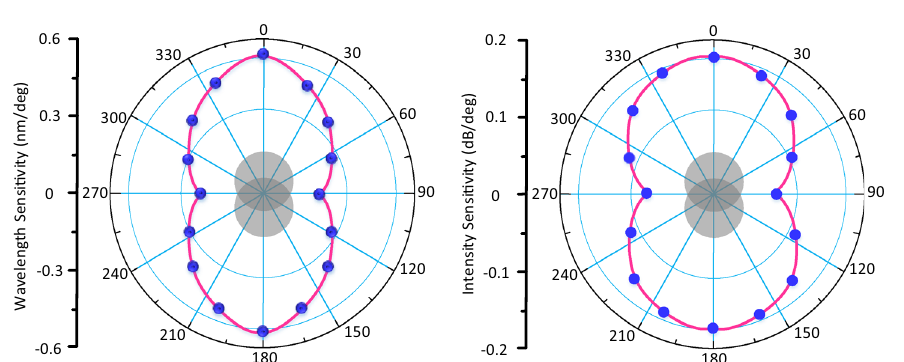
Figure 7. Angular dependence of the inclinometer with respect different